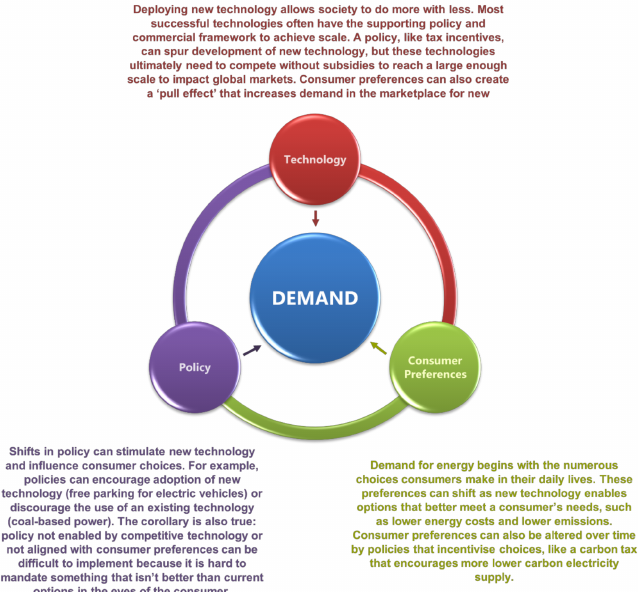
Figure 2. Three key drivers of global energy demand. Source: Modified from